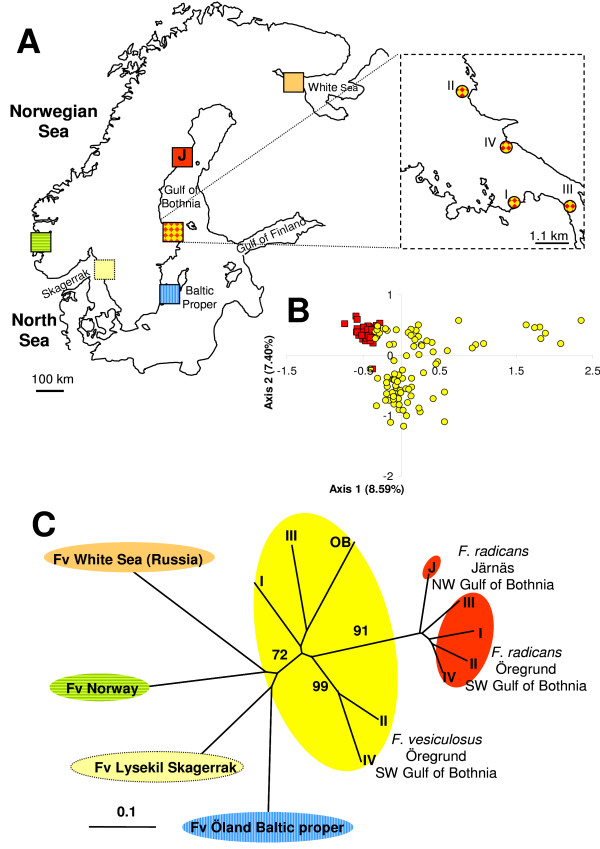
Sampling localities and genetic differentiation of Fucus species. A. Map of Scandinavia showing the main sampling localities and the sampling sites in Öregrund (SW Gulf of Bothnia), where both species occur in sympatry. B. Two-dimensional representation of a factorial correspondence analysis based on microsatellite genotype data. Genotypes are coloured according to species: F. radicans (red squares) and F. vesiculosus (yellow circles). C. Neighbour-joining microsatellite-based population tree calculated with Cavalli-Sforza genetic distances. Fv denotes F. vesiculosus.